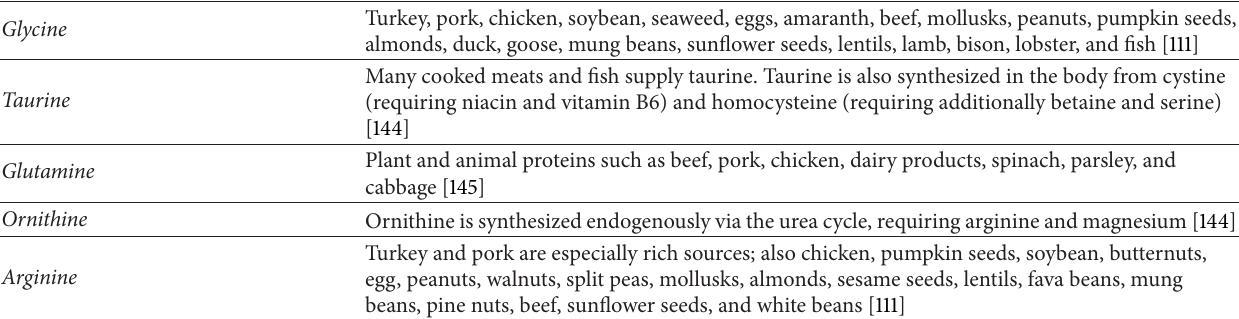
Table 8: Amino acids used in phase II conjugation and selected food